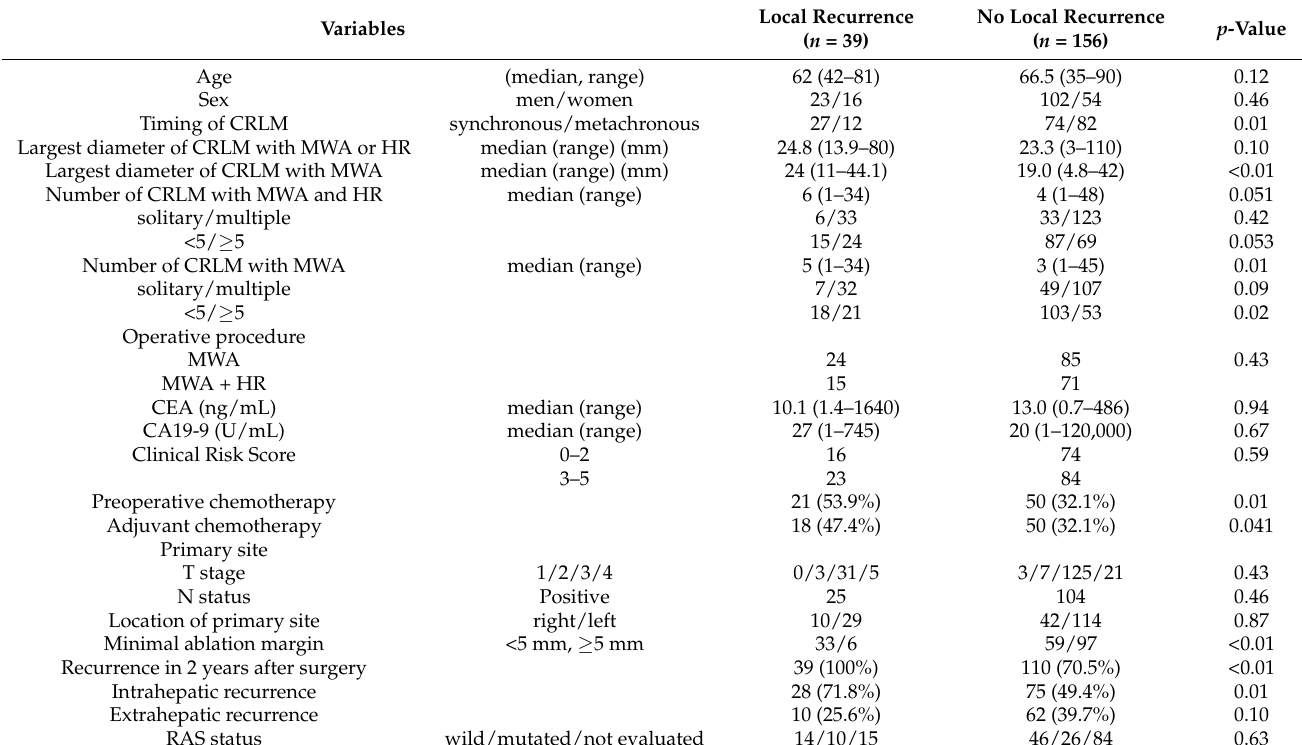
Table 1. Comparison of baseline characteristics of CRLM in patients with and without local recurrence following treatment with MWA.